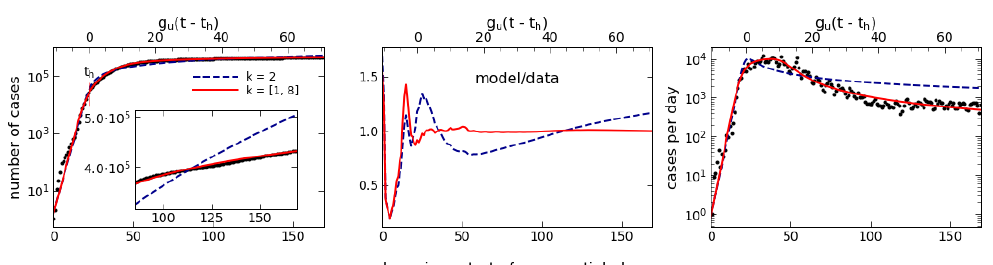
Figure 4. The COVID–19 pandemic first wave in New York State. Dots show the data, dashed and solid lines are best fits with Equation (10) for single- and two-term models, respectively. ( Left ): Cu- mulative number of reported cases from the start of the exponential outburst; this phase ended in the transition to hindering, marked t h . The inset zooms in on the second half of the data with a linear y -axis instead of logarithmic. ( Middle ): Ratio of model to data for each of the fits in the left panel. ( Right ): Daily counts. The model curves involve no fitting, being fully determined from those for the cumulative counts in the left